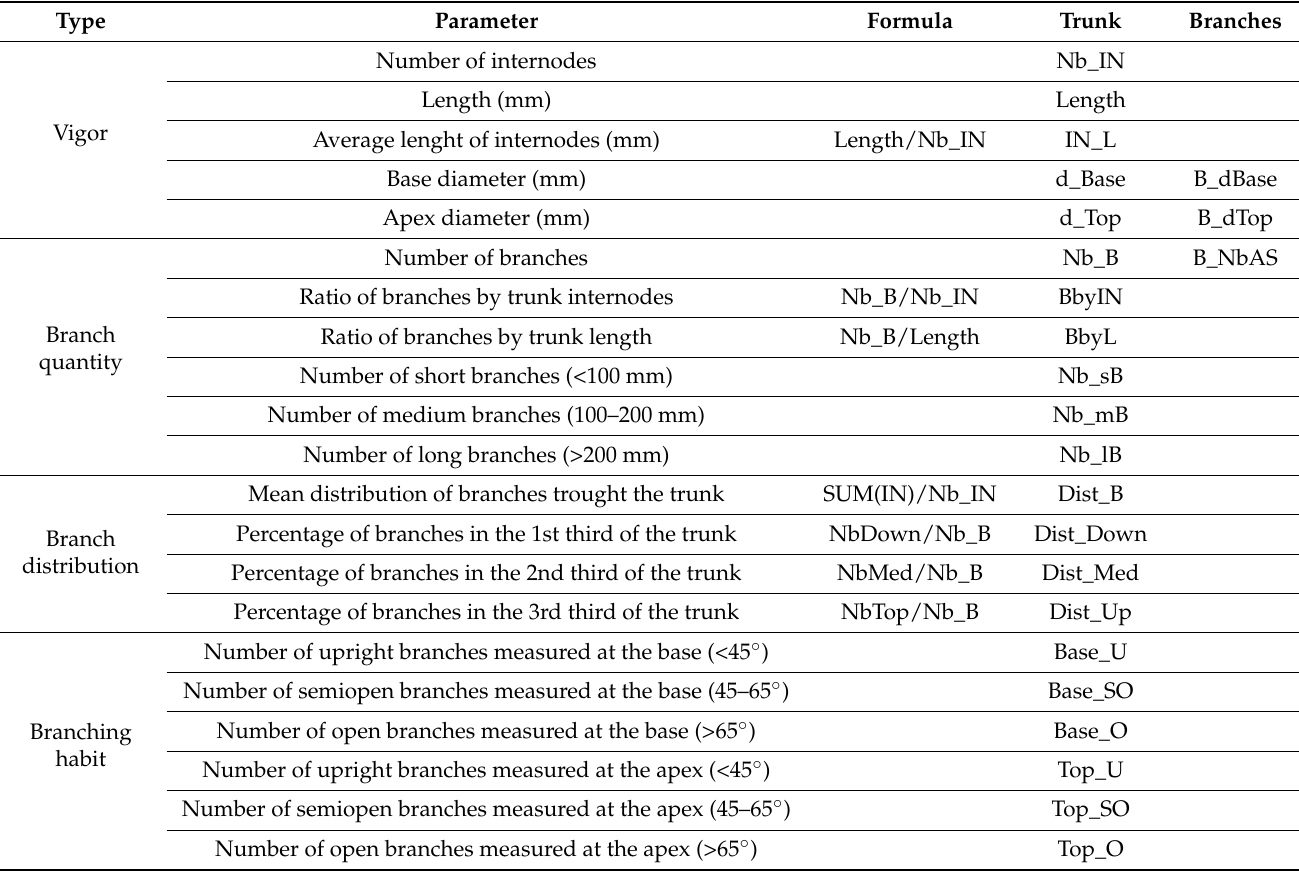
Ratio of branches by trunk